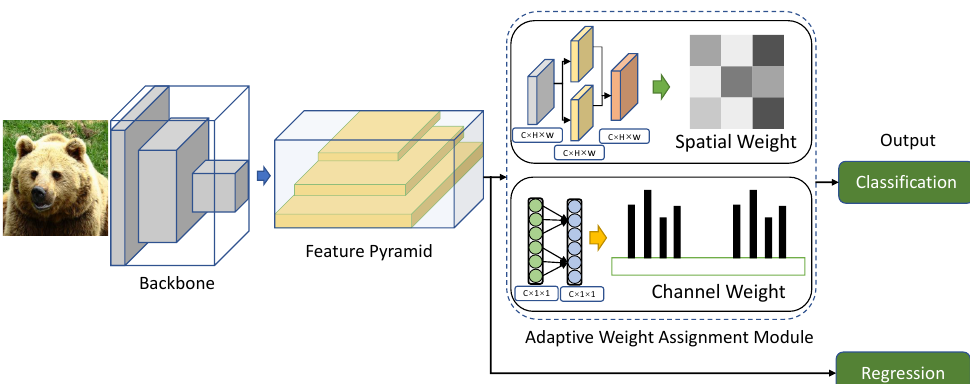
Figure 2. The framework of the proposed object detection algorithm. It mainly includes the backbone, feature pyramid, adaptive weight assignment based on dual attention, regression, and classification. The adaptive weight assignment module based on dual attention involves both spatial weight and channel